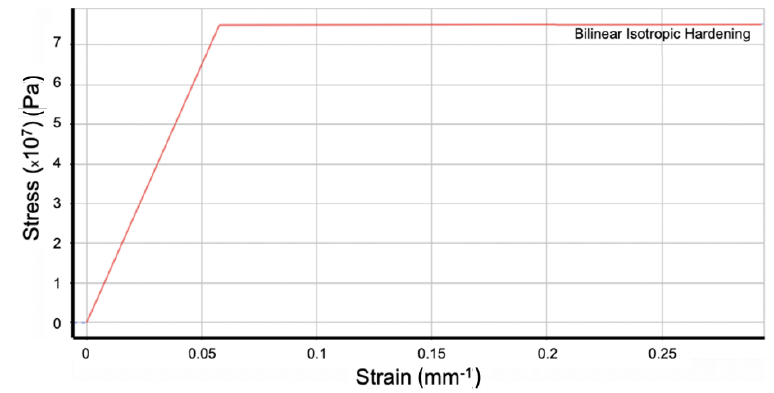
Figure 4. Bilinear isotropic hardening material model (in the case of 75 MPa for the yield strength and